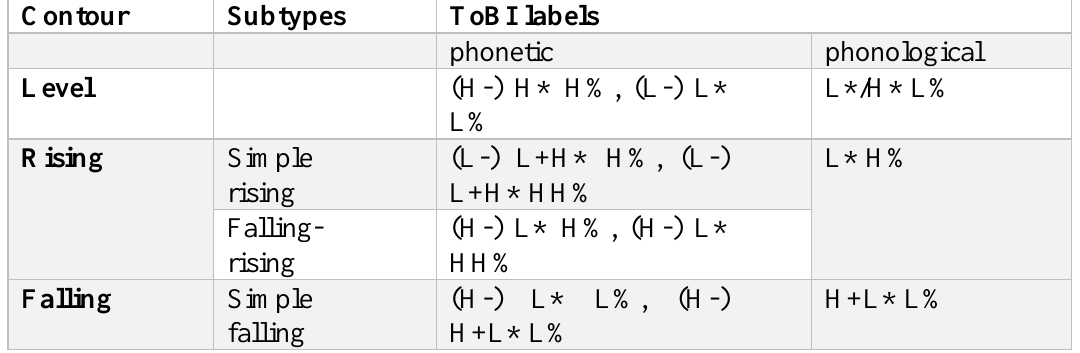
Table 3. Contour types and subtypes with the corresponding ToBI labels reflecting a phonetic and a phonological